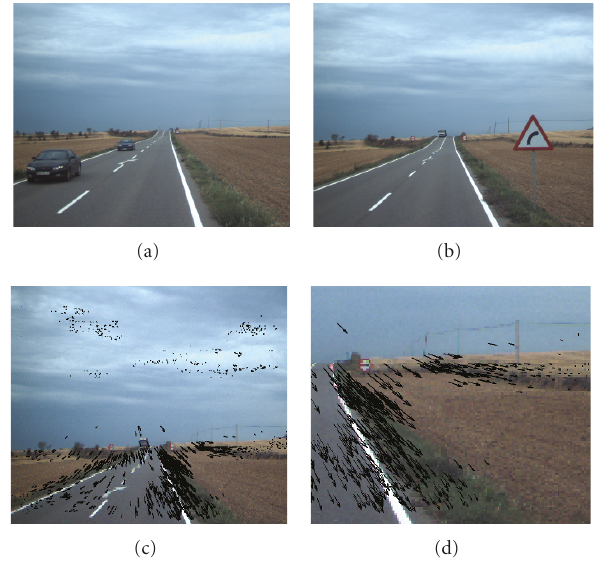
Figure 15: (a), (b) Samples, (c) smoothed oriented CSR matches, and (d) zoomed right